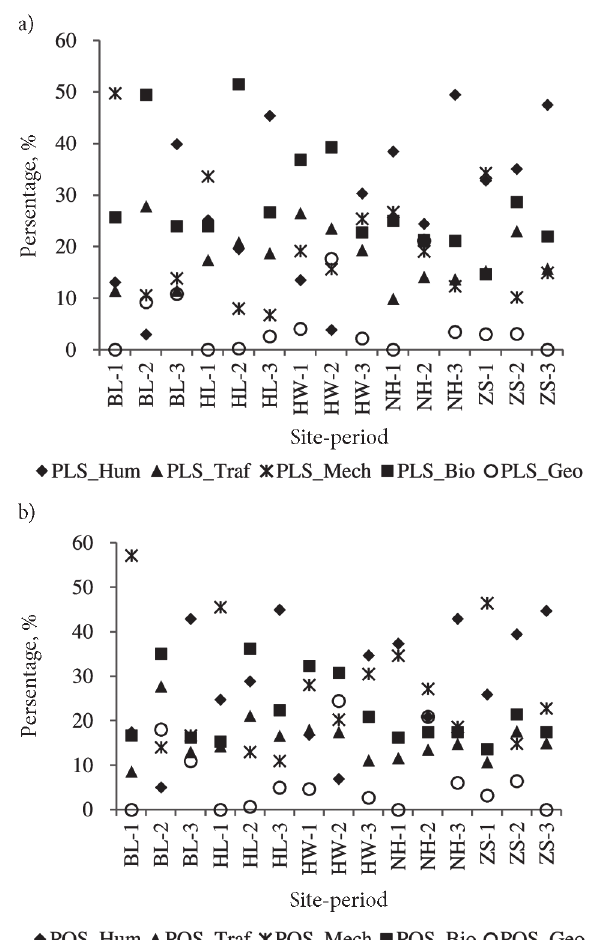
Fig. 3. Perceived loudness (a) and occurrences (b) of individual sound categories in each city park per period (sum of all sampled